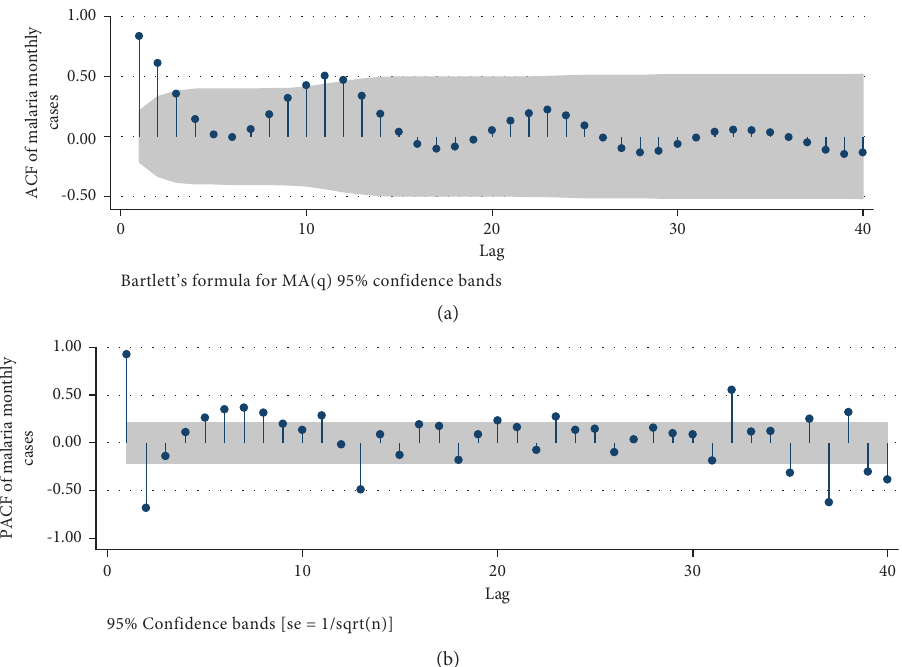
Figure 3: Plot (a) of the autocorrelation function (ACF) and (b) partial autocorrelation function (PACF) for the first-order differenced monthly malaria